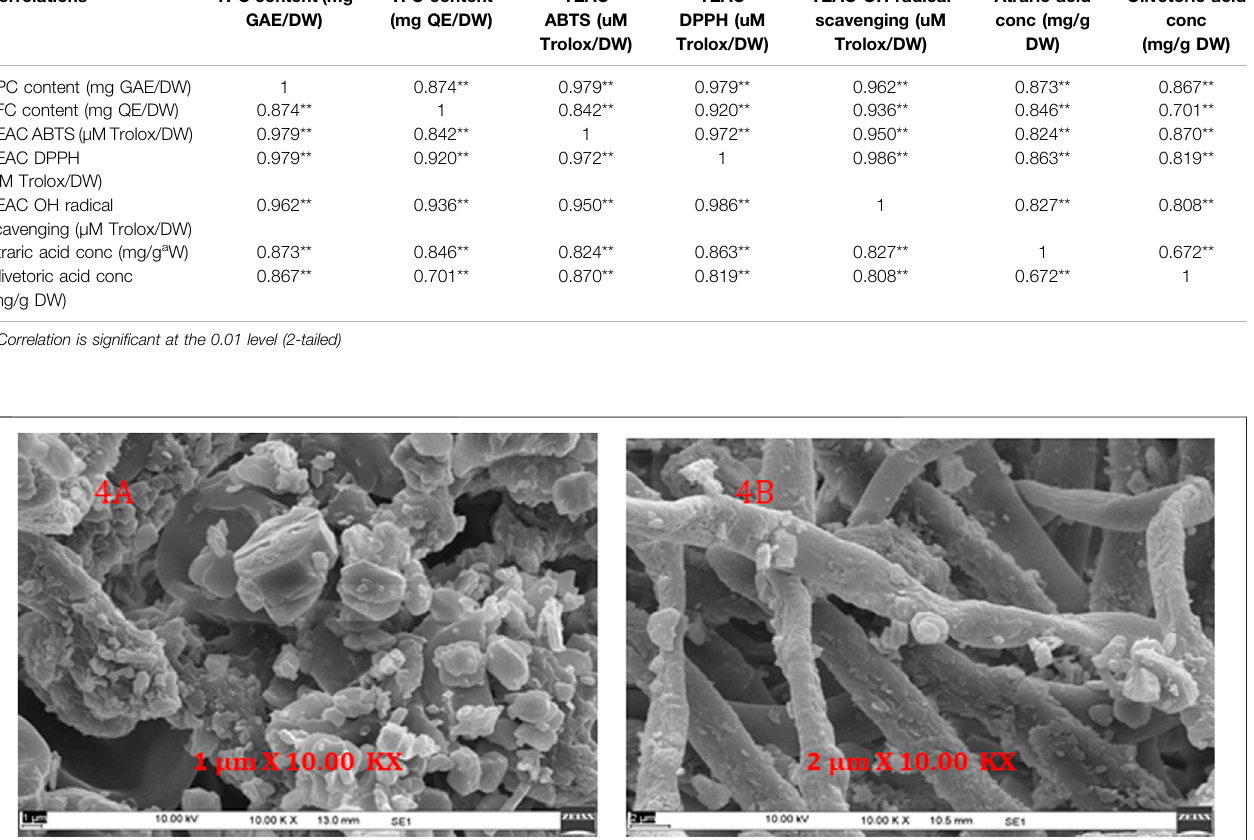
Frontiers in Pharmacology |